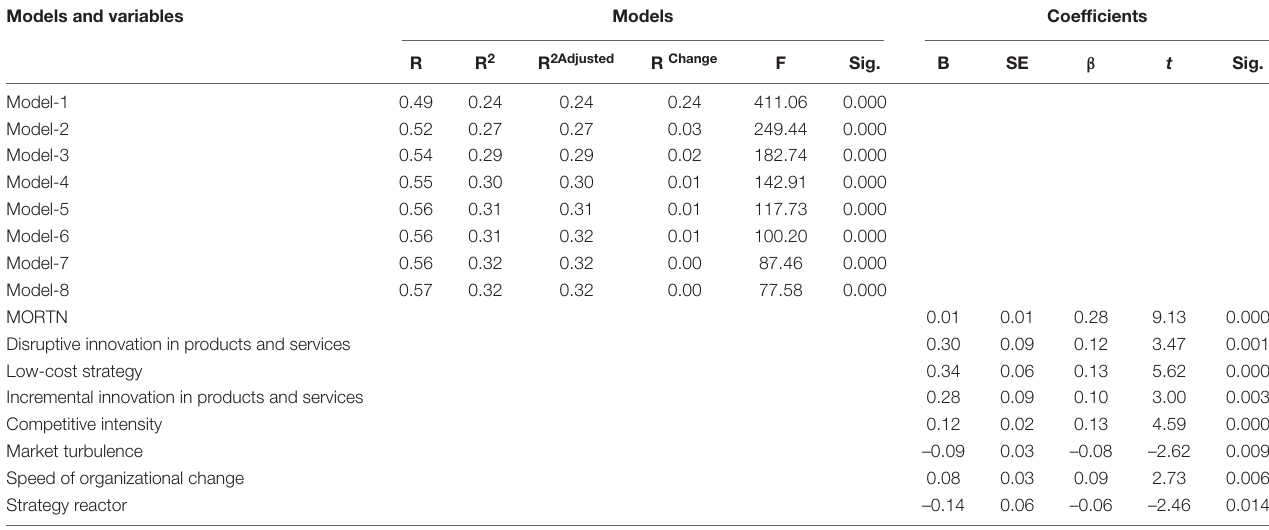
TABLE 5 | Summary of the models, predictive variables, and coefficients of regression analysis (stepwise method): market culture (Peruvian subsample n 2 = 1,317). Models and